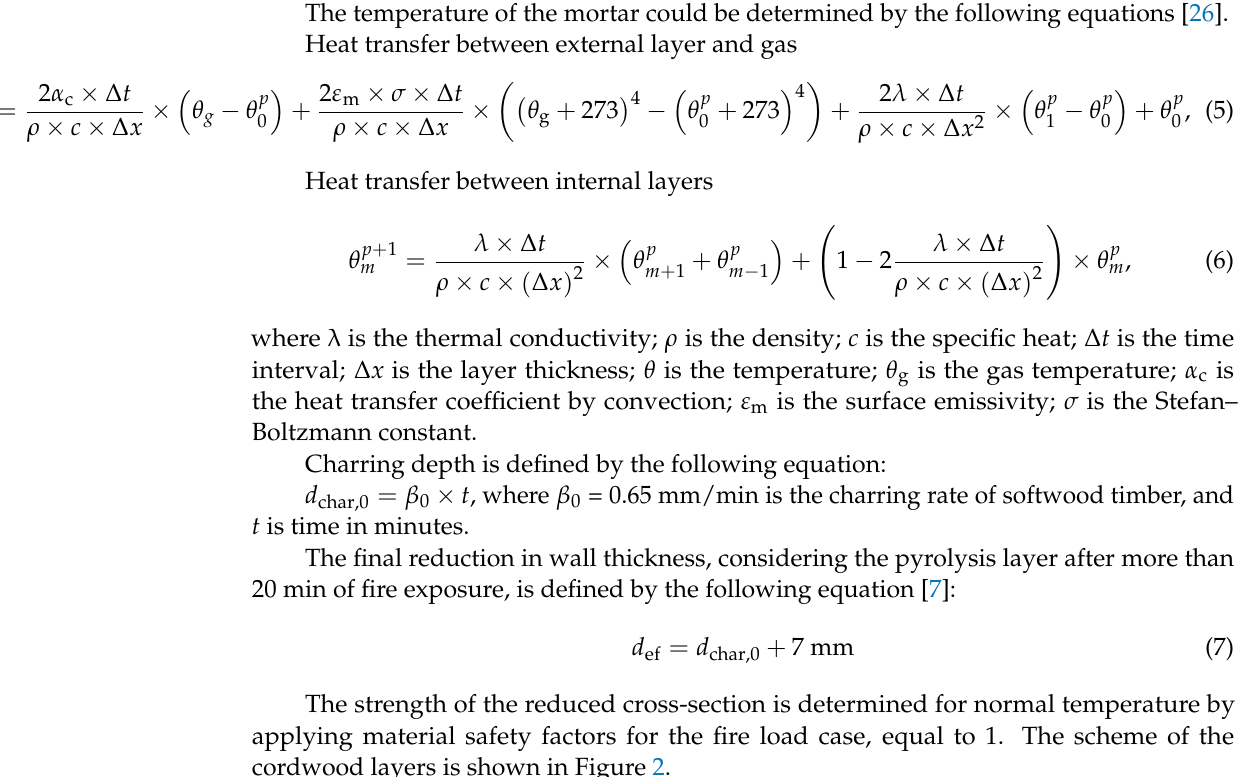
Table 1. Depth of 300 ◦ C isotherms for timber and mortar wall in case of one-sided